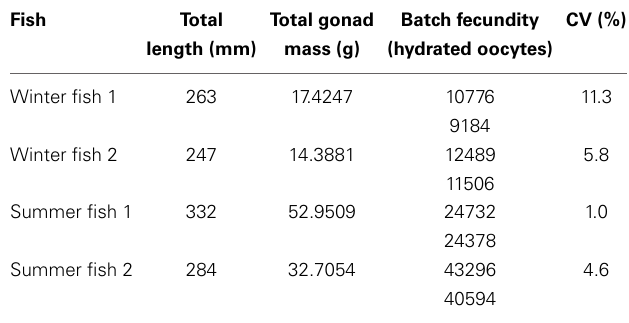
Table 5 | Independently estimated batch fecundities from left and right ovaries.